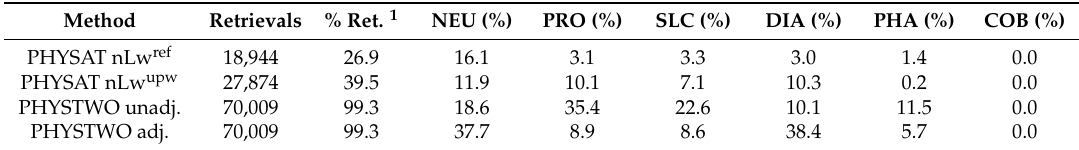
Table 1. The percentage of phytoplankton functional types (PFT) retrievals obtained from the PHYSAT and PHYSTWO methods off central Chile for 4–6 February